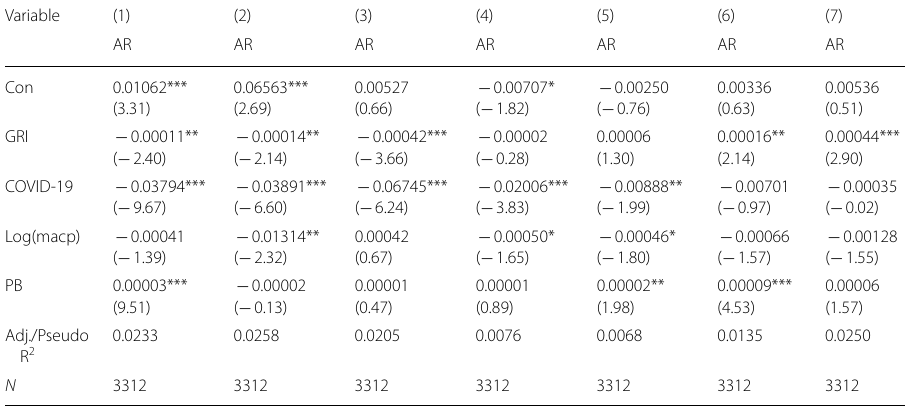
Table 4 Panel regression results of the growth in COVID‑19 confirmed cases and abnormal returns